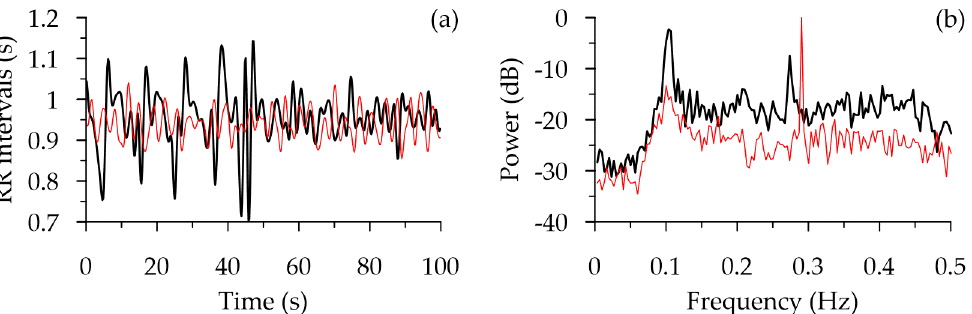
Figure 2. Time series ( a ) and Fourier power spectra ( b ) for the model RR intervals. The black bold lines correspond to a healthy subject, and the red thin lines correspond to the simulation of the blockade of the regulation of respiratory amplitude and frequency.